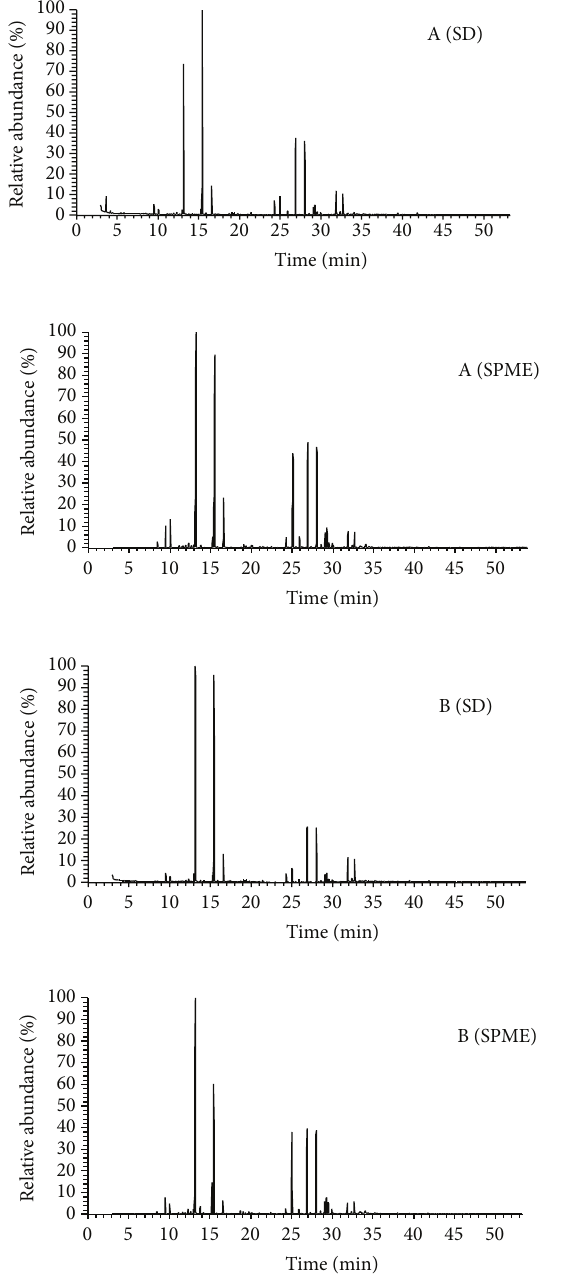
Figure 1: Total ion current chromatograms of volatile components from A. indianum (Lour.) Merr. obtained by SD and HS-SPME from regions A (Guangxi province) and B (Guangdong province), respectively.